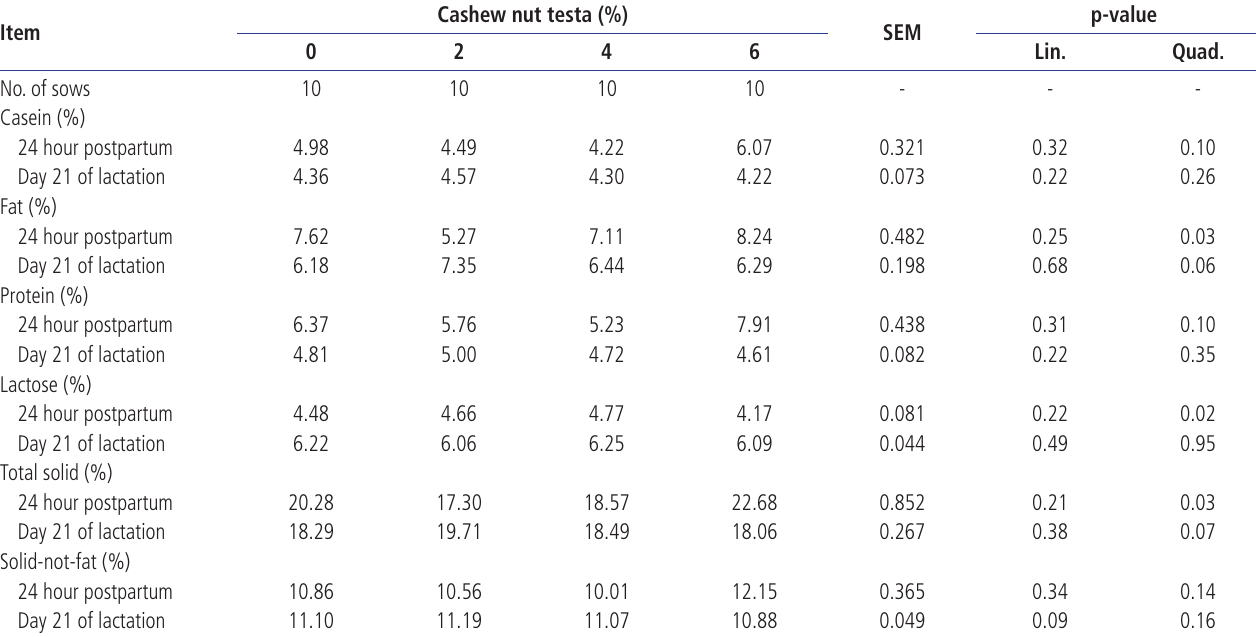
Table 7. Effect of cashew nut testa level on milk composition of gestating and lactating sows